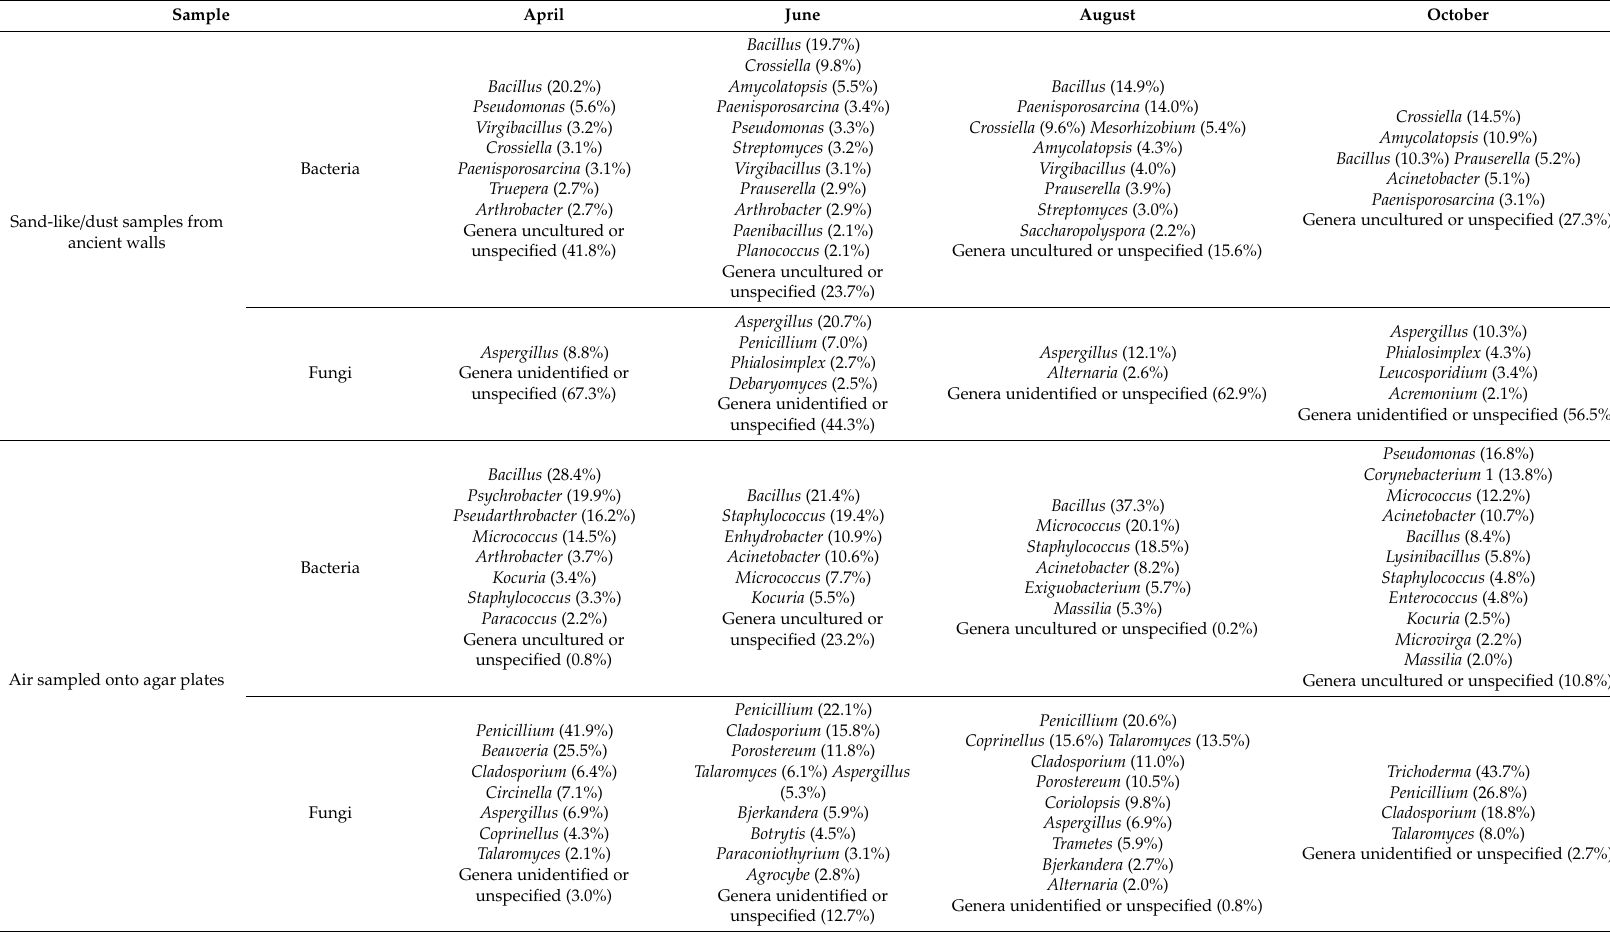
Table 3. The most abundant sequences ( > 2%) assigned to microorganisms at the genera level and cumulatively assigned to uncultured, unclassified, unidentified or unspecified